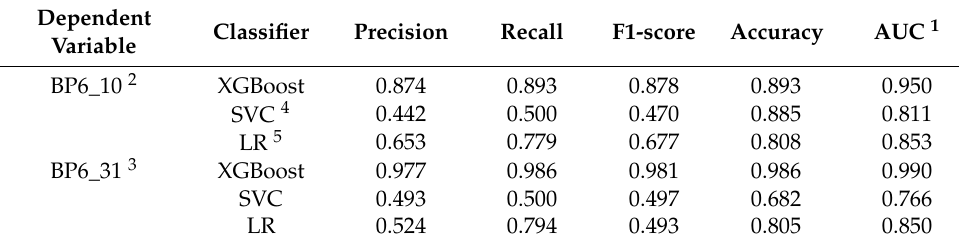
Table 7. Classification performance results for classifiers with integrated